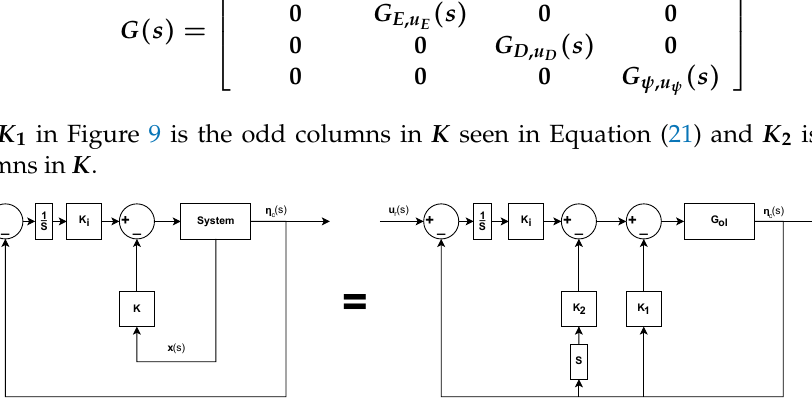
Figure 9. System diagram showing the nominal closed-loop system as state space and linear time- invariant